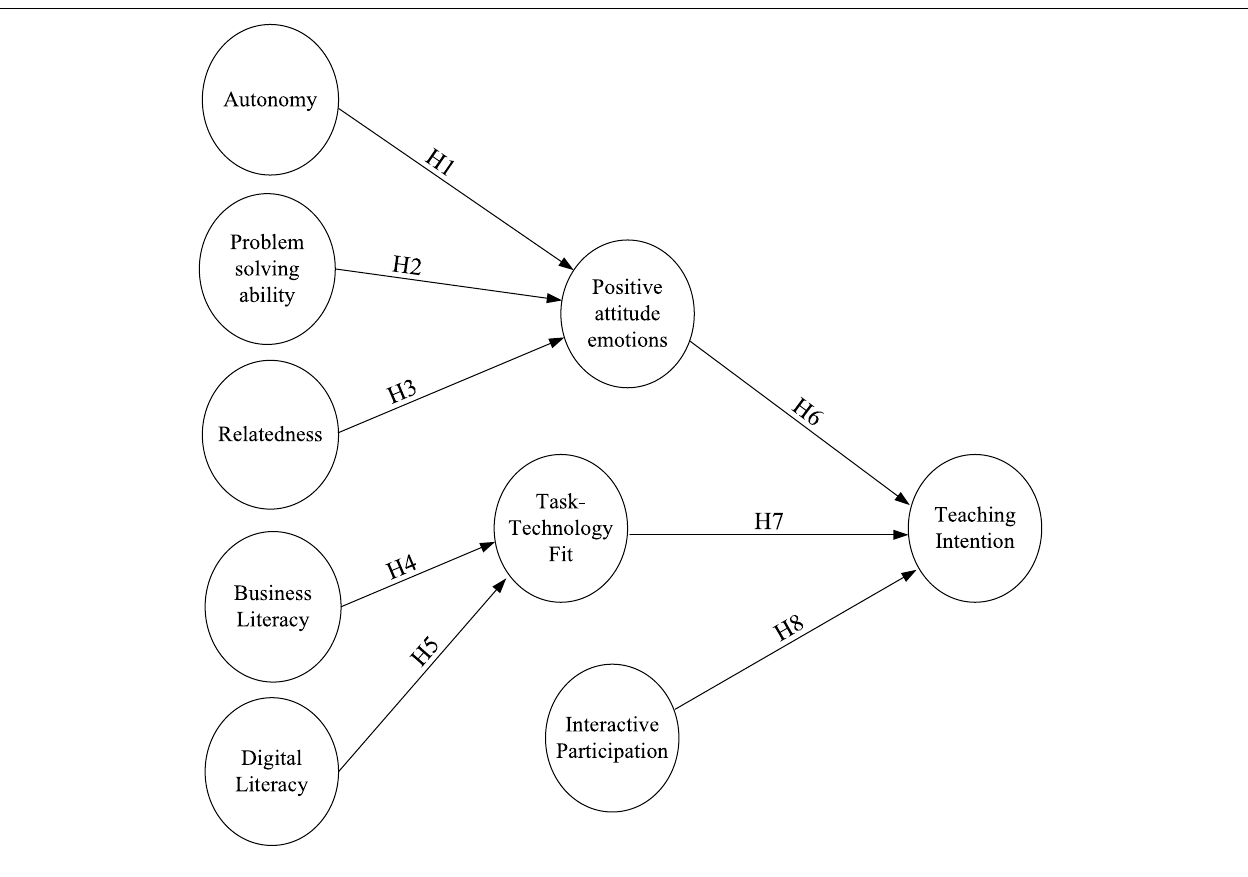
FIGURE 1 | Research